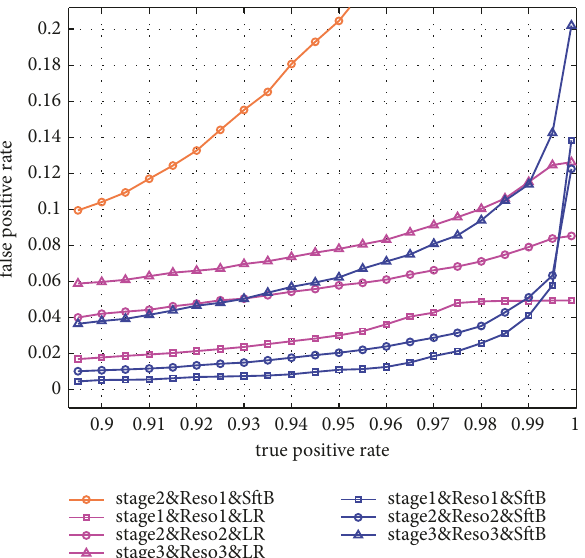
Figure 4: ROC curves for different stage-classifiers which are calculated from the test set generated during the training period.